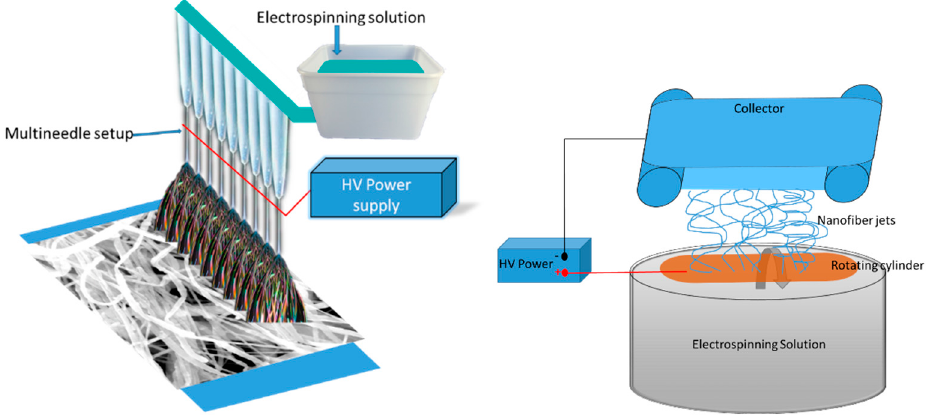
Figure 9. Schematic representation of multiple needle and needleless electrospinning set up for generating higher yields.